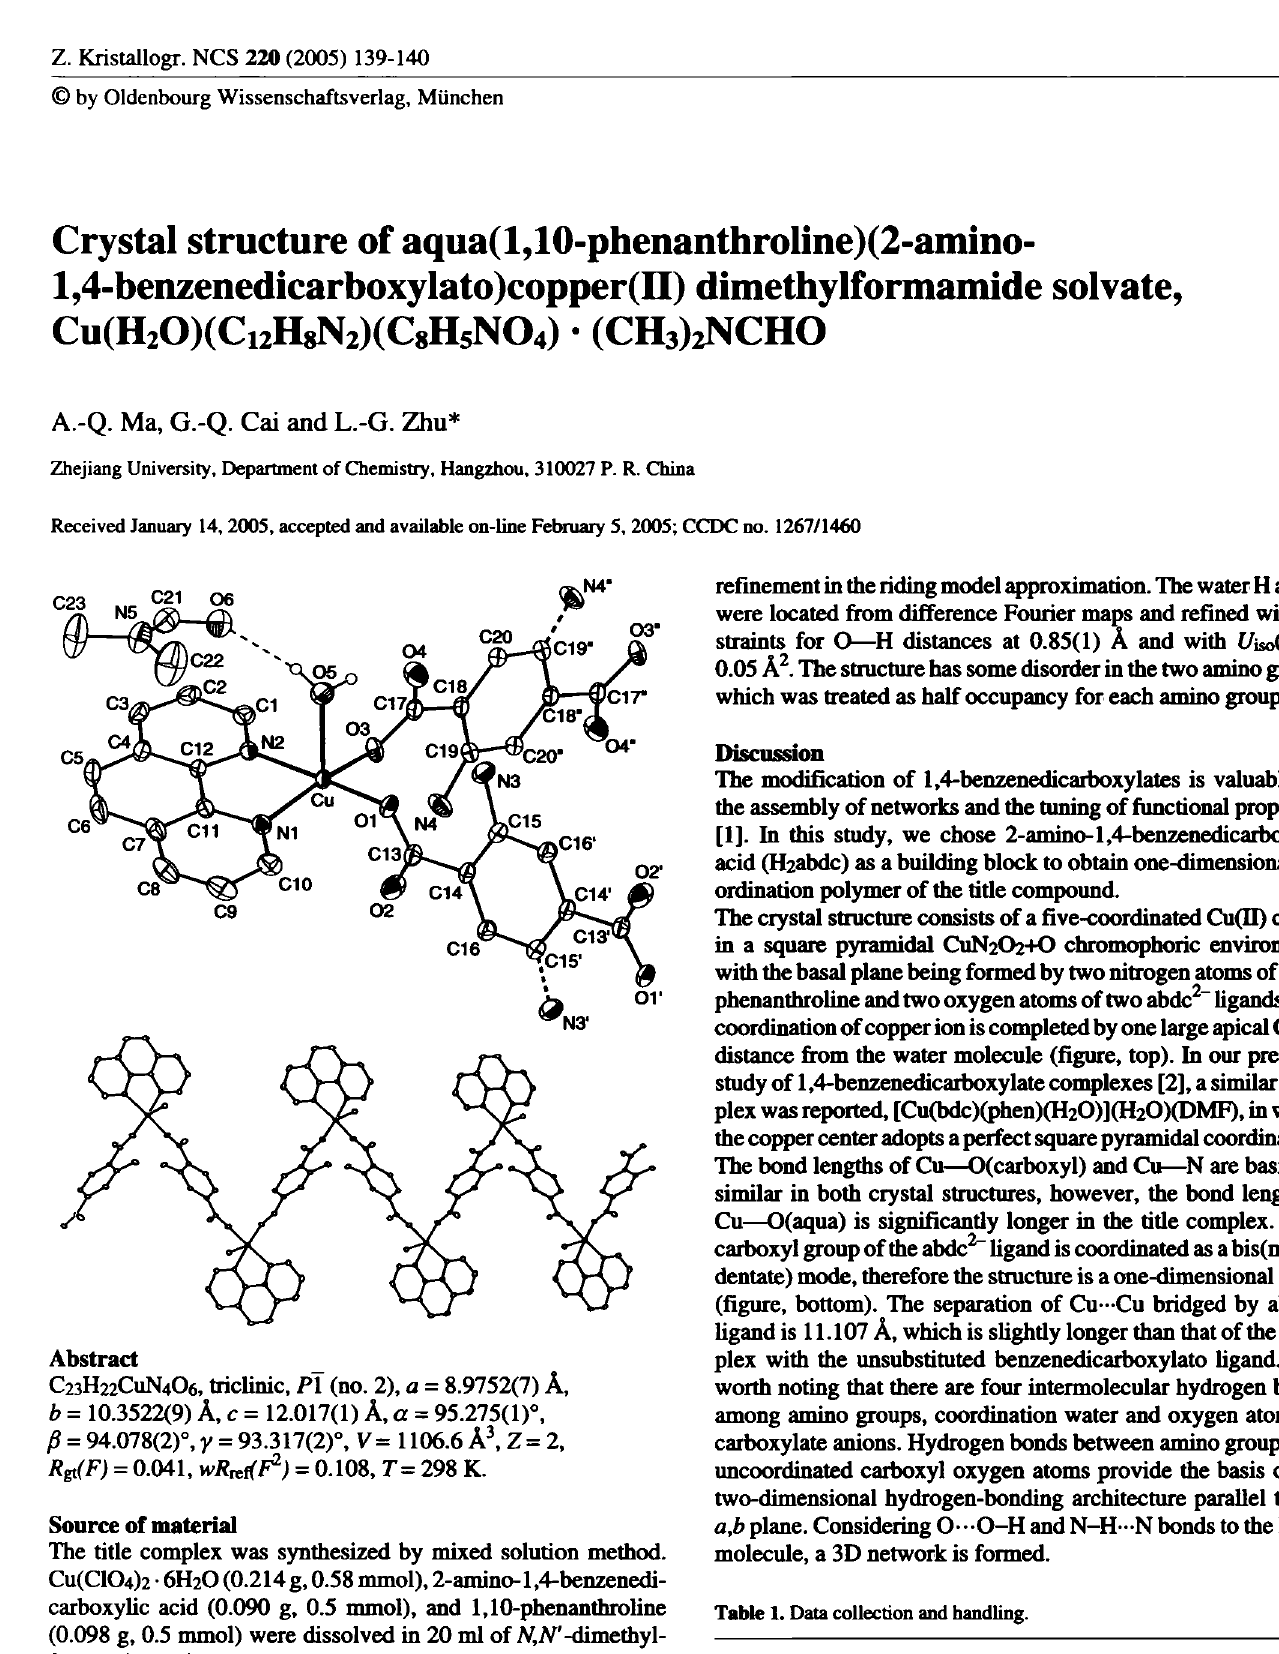
Table 1. Data collection and handling. Crystal: